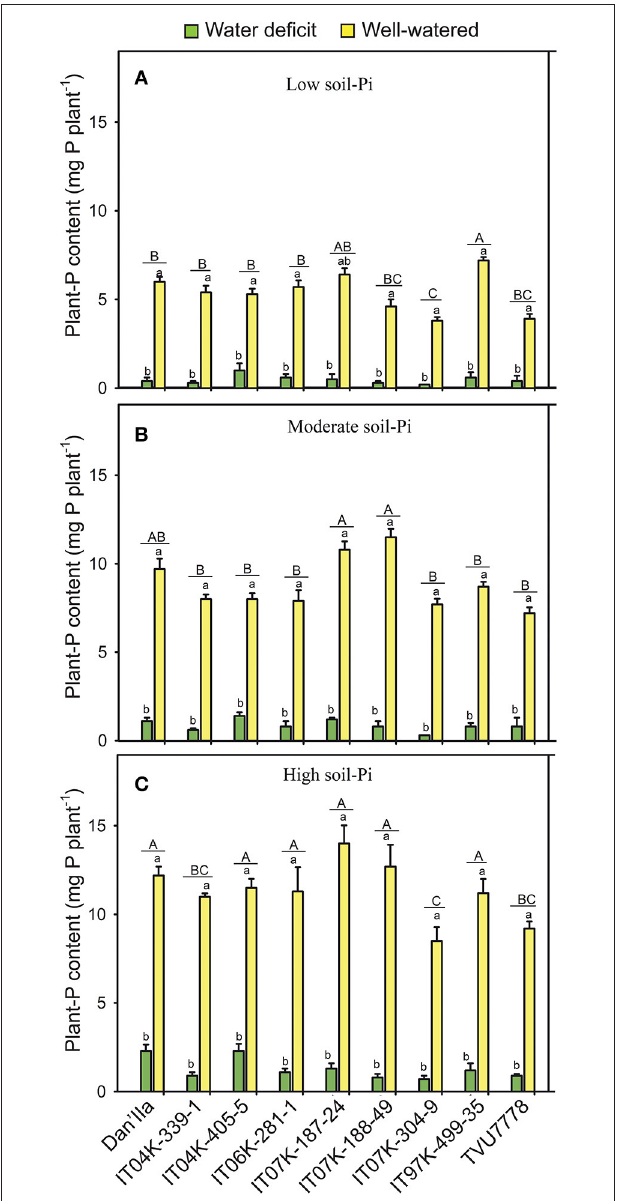
FIGURE 2 | Plant-phosphorus (P) contents in cowpea varieties under different available soil-phosphate (Pi) levels with or without water deficit stress. (A) Low soil-Pi, (B) moderate soil-Pi, and (C) high soil-Pi. Mean values and standard errors (bars) are shown ( n = 4). Different small letters indicate significant differences between the water-deficit and well-watered plants for each variety at each available soil-Pi level (Fisher’s test; p < 0.05). Different capital letters indicate significant differences among the varieties at each available soil-Pi level (Fisher’s test; p < 0.05).